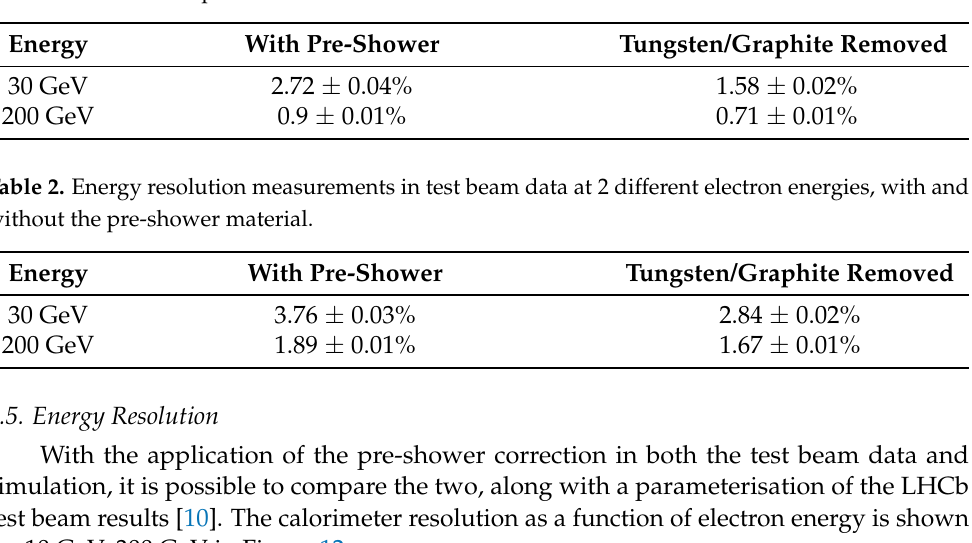
Figure 11. The fraction of beam energy deposited in the calorimeter for a simulated 30 GeV electron, with the tungsten/graphite material removed from the pre-shower station (blue), compared to the default simulation setup (red). Table 1. Energy resolution measurements in test beam simulation at 2 different electron energies, with and without the pre-shower material.